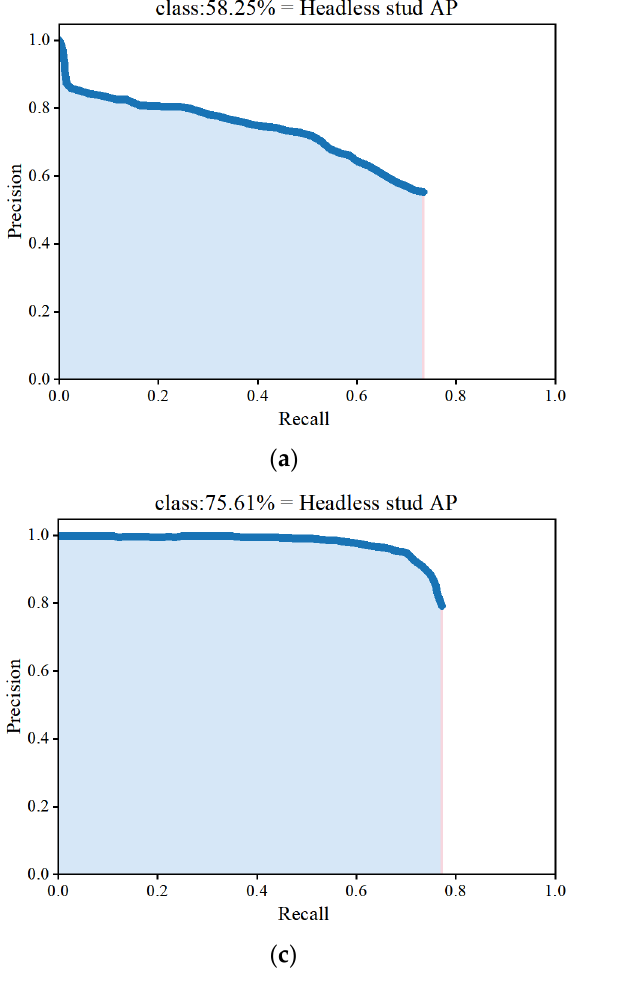
Figure 7. P-R curves of four methods on the studs dataset. ( a ) SSD; ( b ) Faster R-CNN; ( c ) YOLOv3; ( d ) Improved YOLOv3.